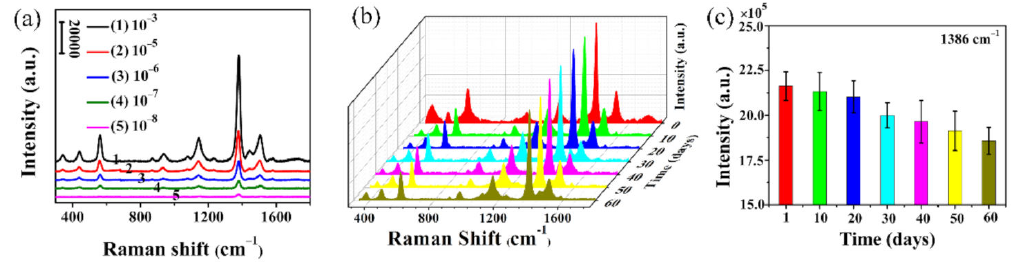
Figure 9. SERS spectra of thiram with di ff erent concentrations adsorbed on Ag@T-A@SiO 2 @Au-20 nanofibrous membranes ( a ), SERS stability spectra of 10 − 5 mol / L thiram on Ag@T-A@SiO 2 @Au-20 nanofibrous membranes exposed in the atmosphere for 60 days ( b ), the peak intensity changes at 1386 cm − 1 for thiram with standing time ( c